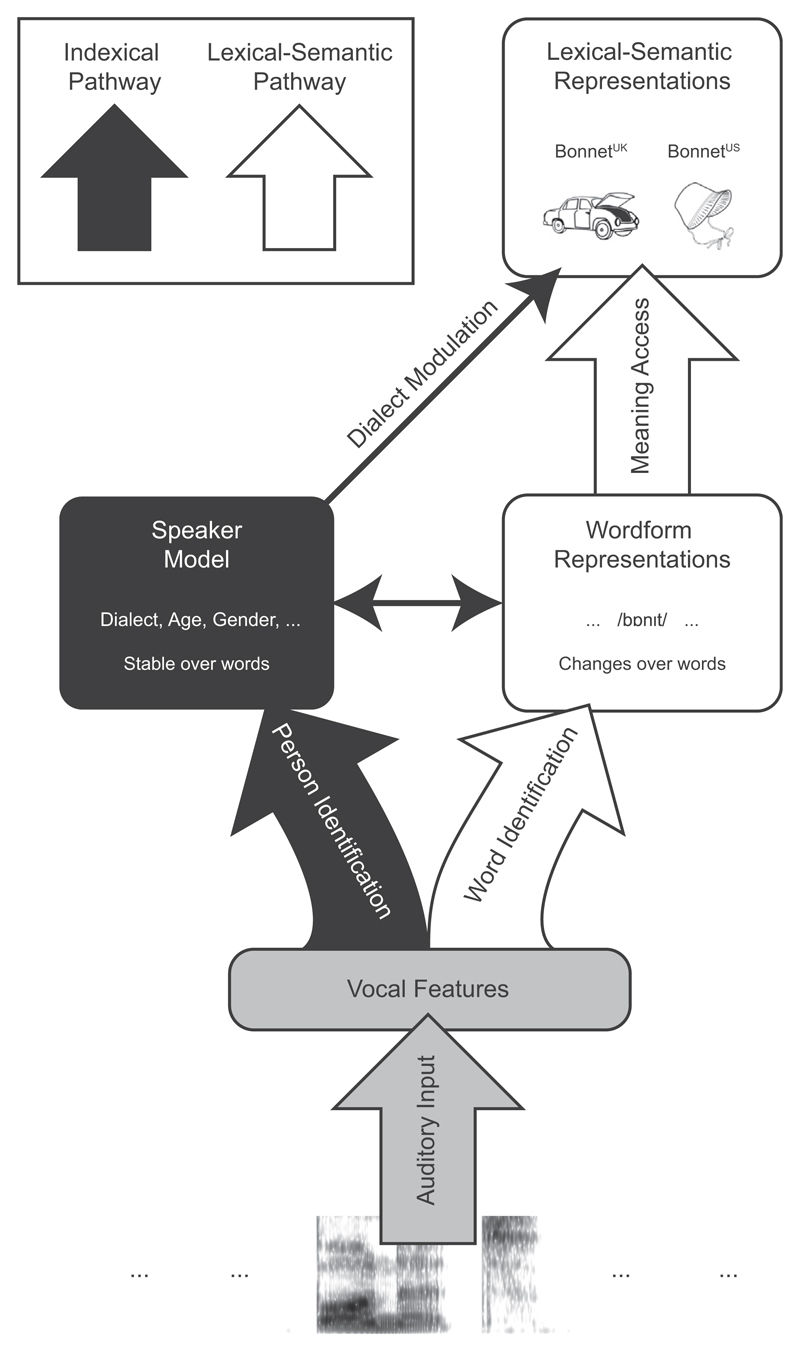
A model of spoken word comprehension which incorporates both lexical-semantic and indexical pathways. The incoming speech signal contains information concerning who is speaking (indexical information) and what they are saying (phonetic information). These information sources are processed in separate, but interacting, pathways. White (unfilled) arrows represent the lexical-semantic pathway, in which speech information is used to identify wordform representations, that in turn allow direct access to lexical-semantic representations; black (filled) arrows represent an indexical pathway, in which information in the speech signal is used to infer characteristics of the speaker, which in turn can be used to modulate lexical-semantic processing (as shown by dialect modulation in the present studies).